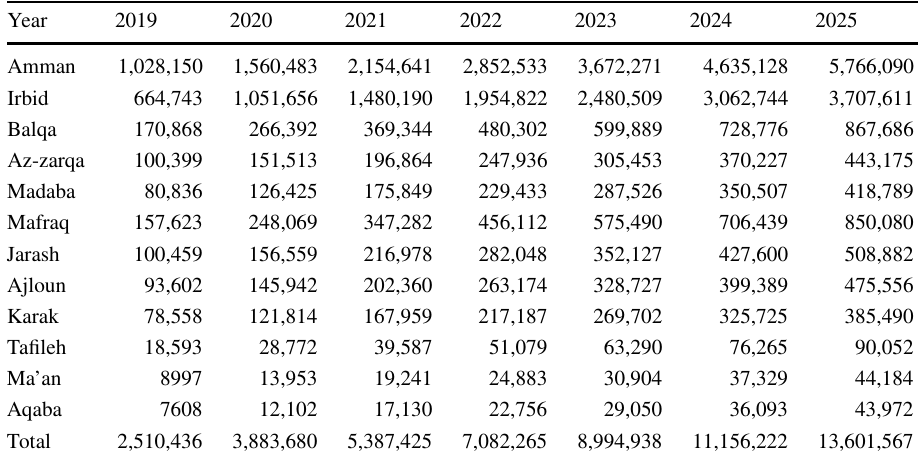
Table 4 Potential of water harvesting in scenario